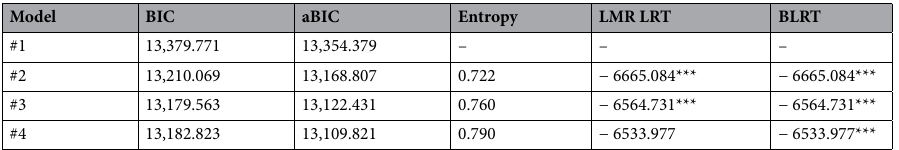
Table 2. LCA model fit indices. LCA latent class analysis, BIC Bayesian information criterion, aBIC sample size adjusted BIC, LMR LRT Lo-Mendell Rubin likelihood ratio test, BLRT bootstrap likelihood ratio test. # Number of classes. ***p <